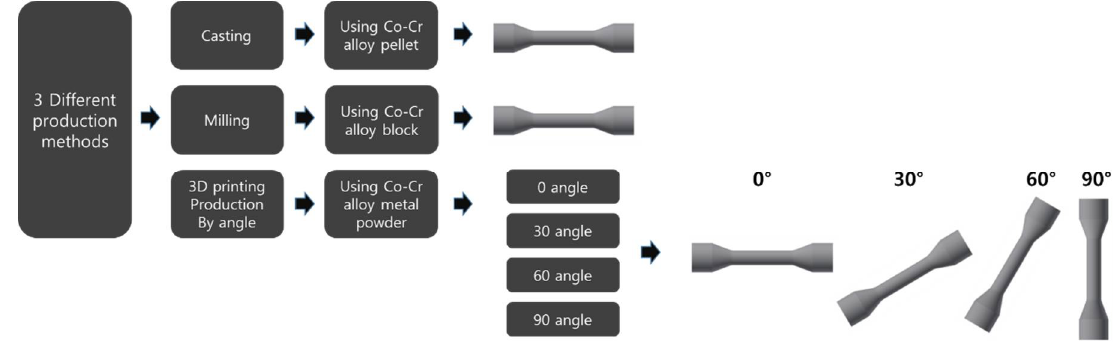
Figure 1. Three methods of manufacturing specimens for comparison of mechanical properties.